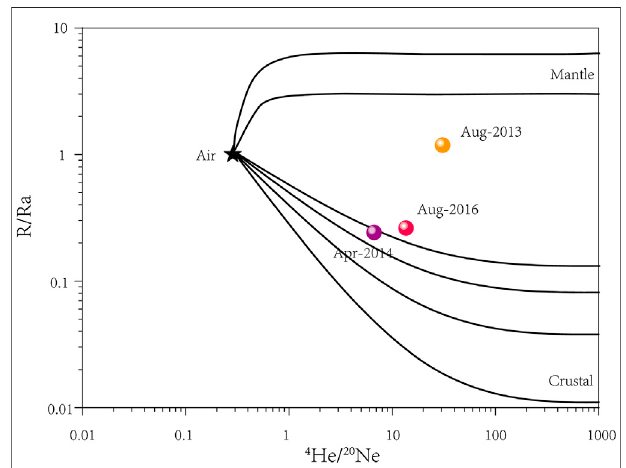
FIGURE 9 | Relationship between the R/Ra and 4 He/ 20 Ne ratios of hydrothermal gas in the Panjin observation well.